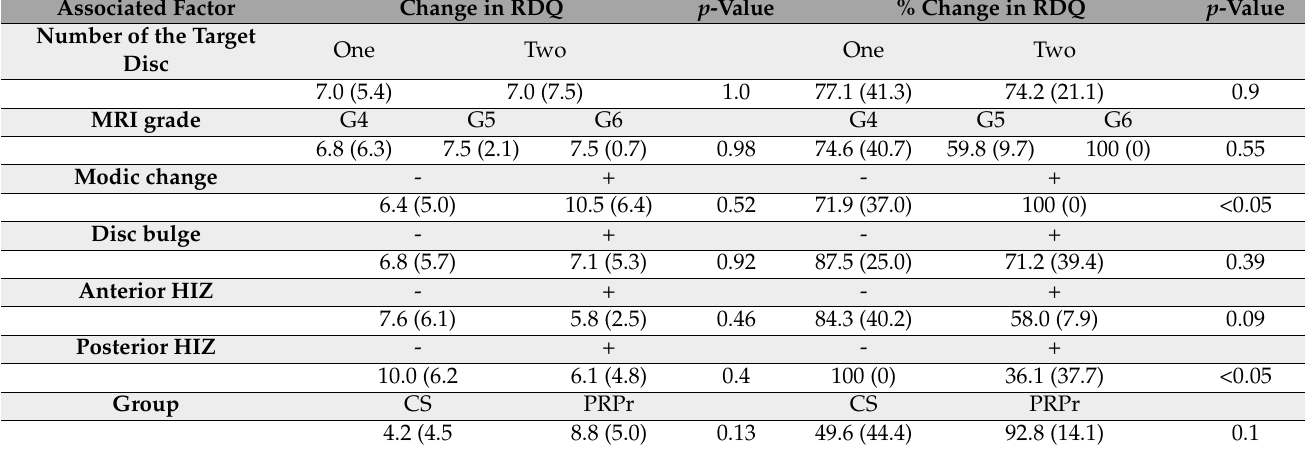
Table 4. Factors associated with RDQ.